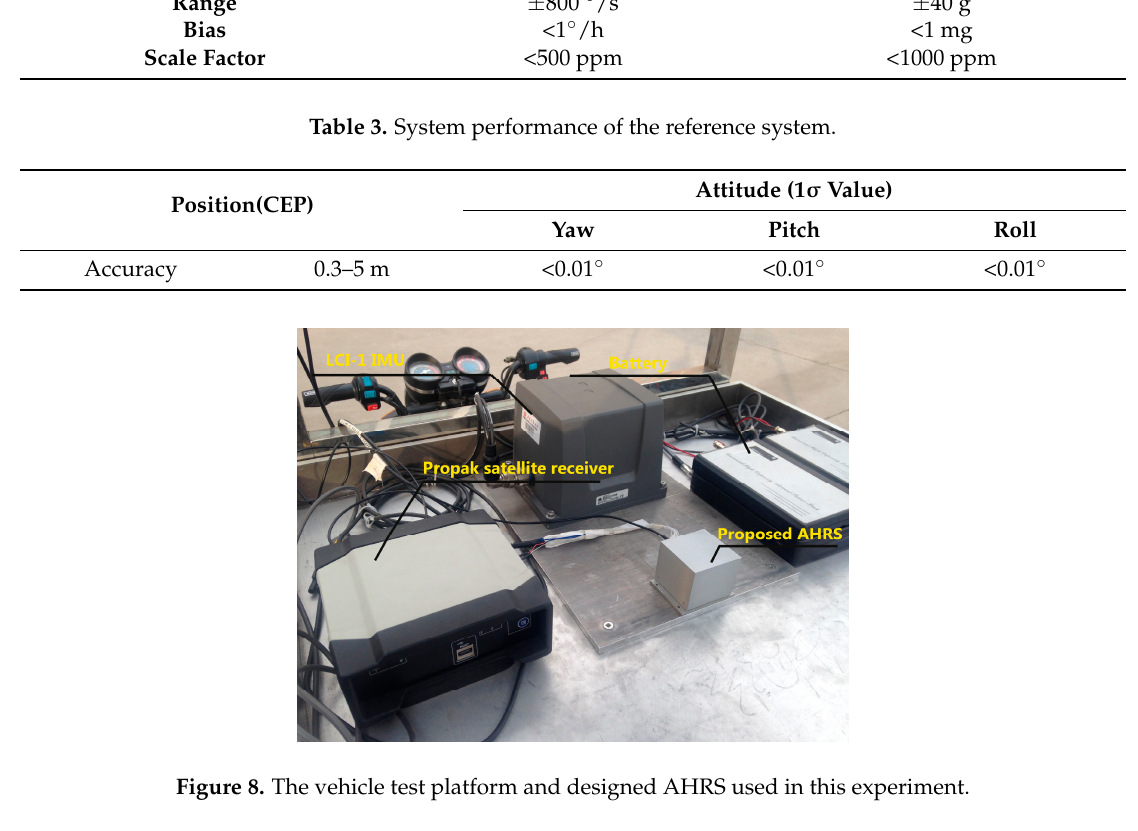
Figure 8. The vehicle test platform and designed AHRS used in this experiment.